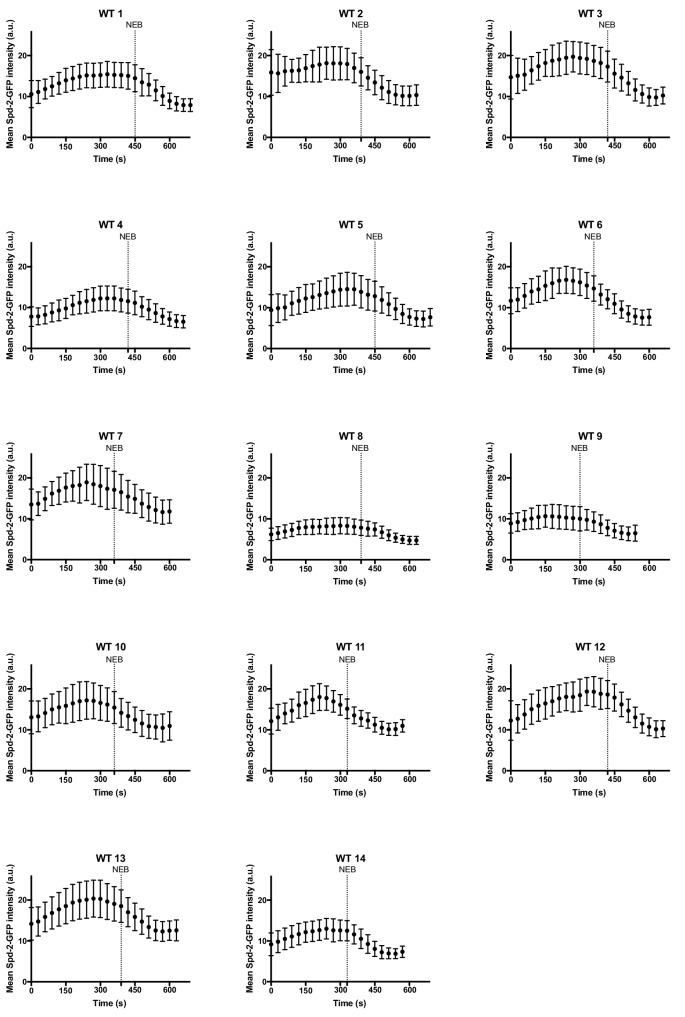
Centrosome maturation dynamics in Spd-2 mutant embryos rescued by WT Spd-2-GFP.Graphs show the mean ± SD centrosomal WT Spd-2-GFP intensity (in arbitrary units [a.u.]) through an entire embryonic cell cycle (nuclear cycle 12) for 14 different embryos. Number of centrosomes analysed per embryo = 52–171. Time (s) is indicated; t = 0 was set as the time that centrosomes first separated at the start of S-phase. Dashed lines indicate nuclear envelope breakdown (NEB).